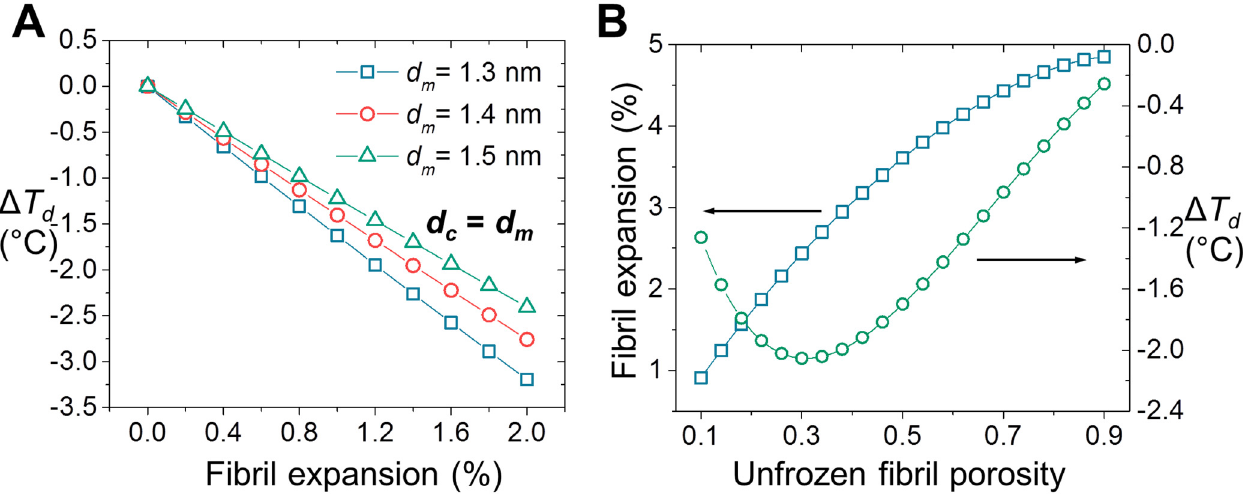
Fig 6. Prediction of denaturation temperature decrease upon F/T by computational modeling. (A) The change in denaturation temperature upon hypothetical expansion of a tightly packed fibril (minimum porosity). (B) The amount of freezing-induced fibril expansion and change in denaturation temperature as a function of unfrozen fibril